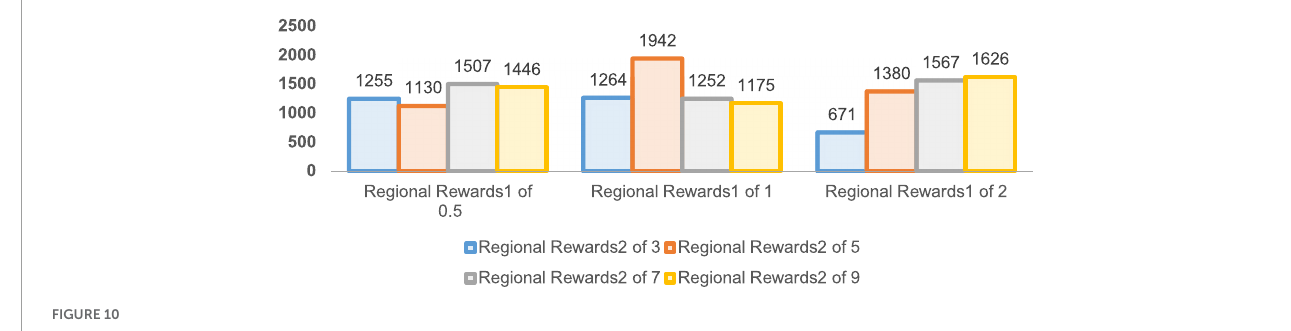
FIGURE10 Number of successes in 5,000 rounds of regional reward training.